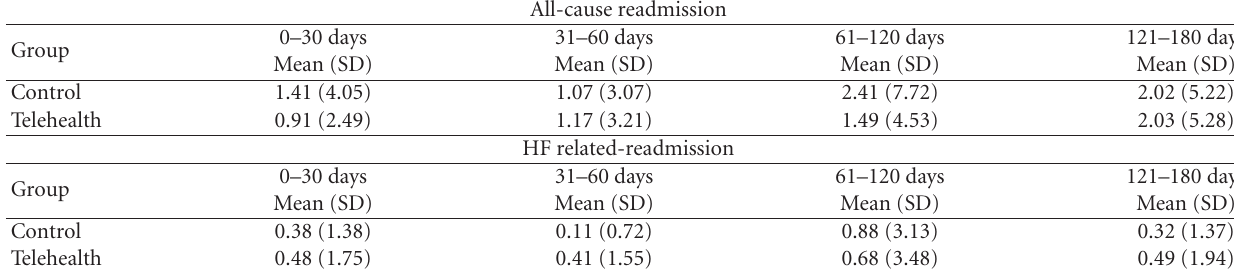
Table 6: Mean and SD of hospital days by time period and group.